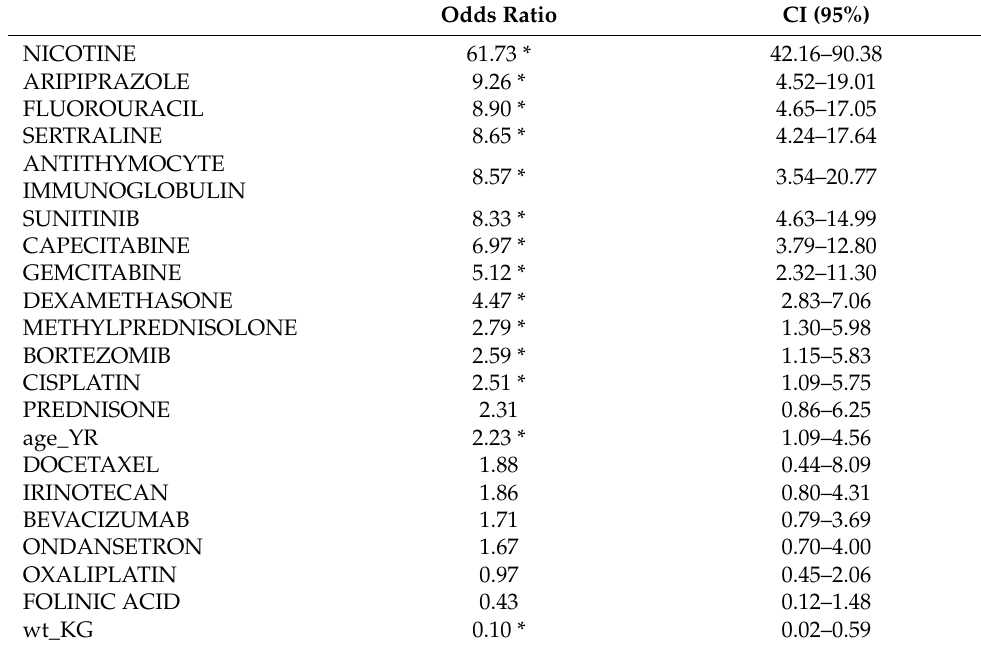
Table 3. Results of a multiple logistic regression using the male data table.